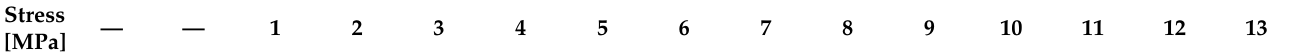
Table 5. Failure–not-failure sequence at staircase involving specimens of Sets HMP-U-M-D.